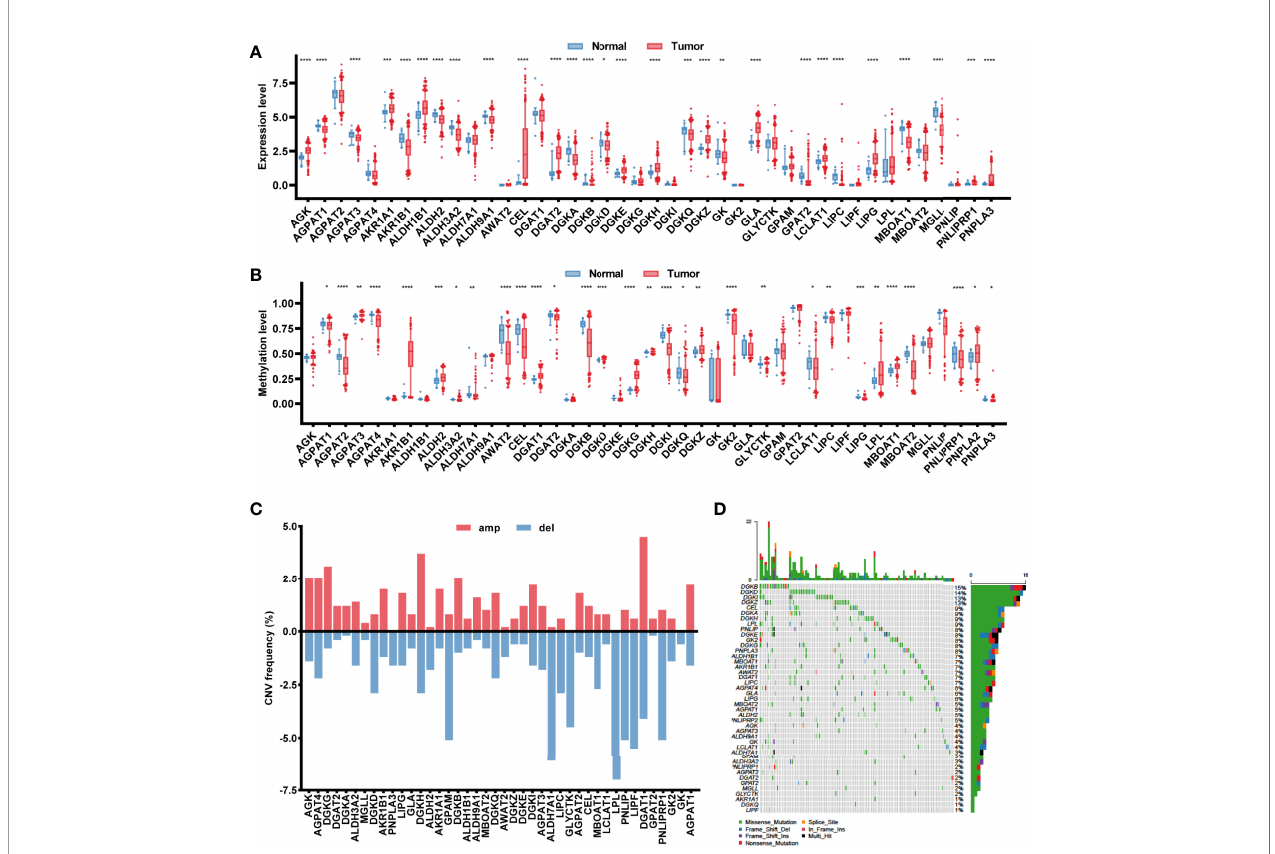
FIGURE 1 | Characterization of the glycerolipid metabolism genes in colon cancer patients. (A, B) The mRNA expression (A) and methylation (B) of the glycerolipid metabolism-related genes between tumor and normal tissues from TCGA database. (C, D) Copy number variation (CNV) frequency showing gene ampli fi cation (amp) and deletion (del) (C) and mutation oncoprint (D) of 42 glycerolipid metabolism-related genes in 430 tumor tissues from TCGA-COAD cohorts. * P < 0.05; ** P < 0.01; *** P < 0.001; and **** P < 0.0001 by the Mann – Whitney